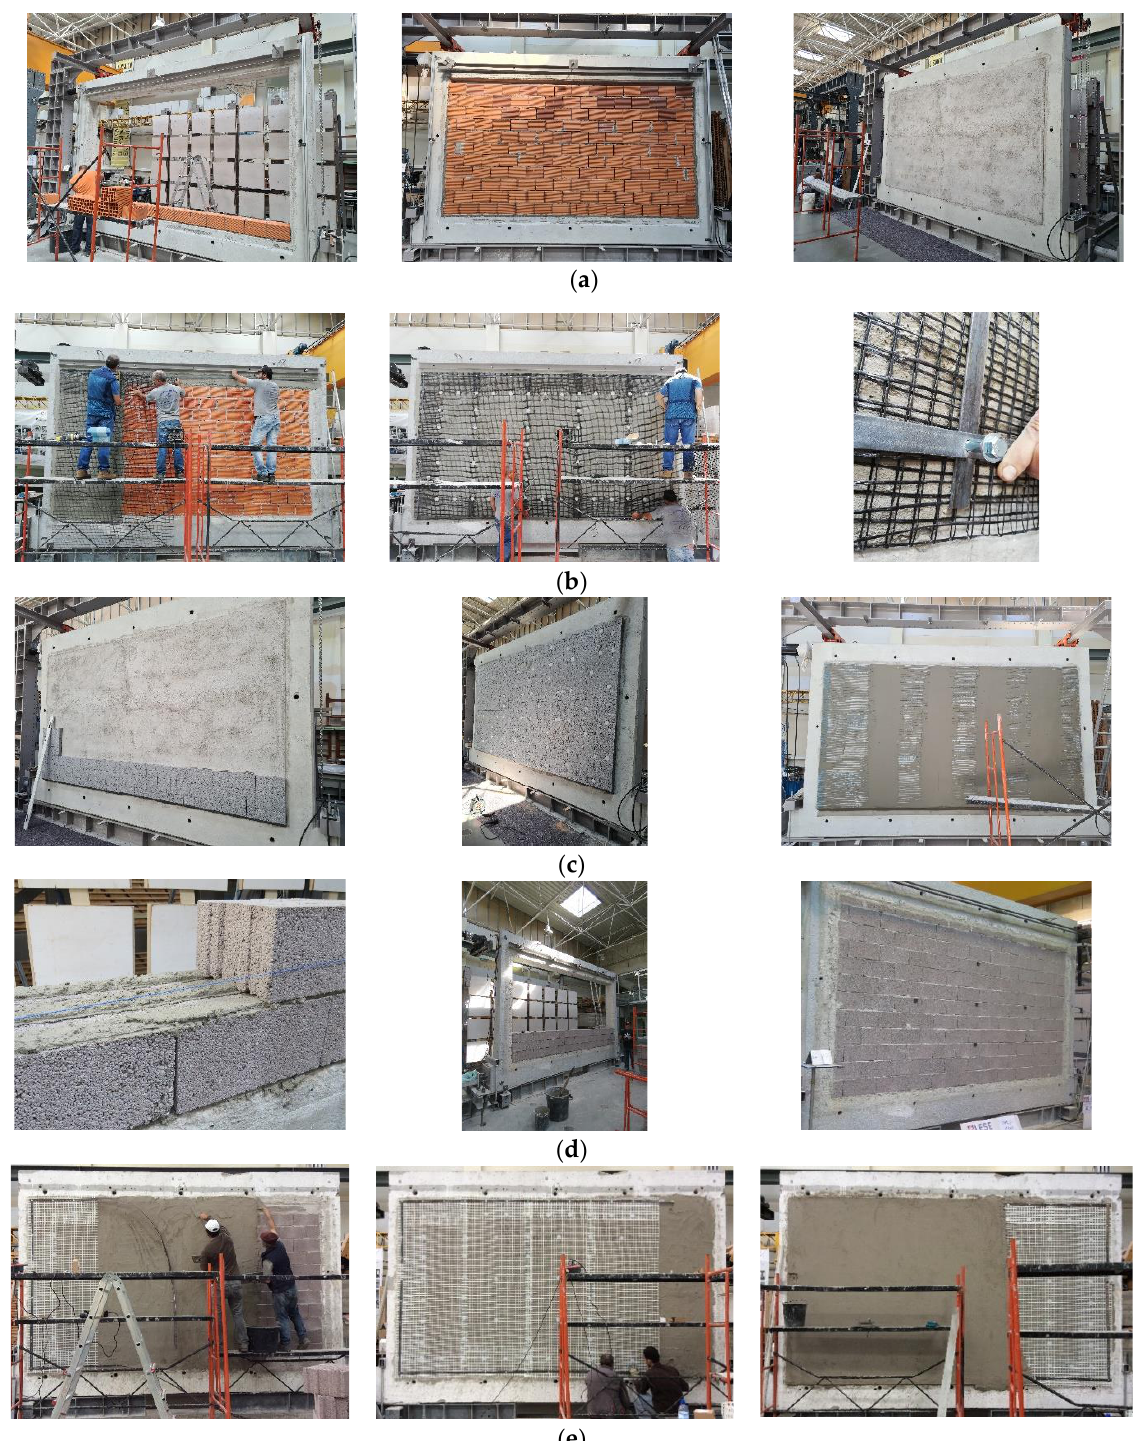
Figure 5. Wall construction procedure: ( a ) type 1; ( b ) type 2; ( c ) type 3; ( d ) type 4; ( e ) type 5. Wall type 4 consisted of a wall built with lightweight vertical hollow concrete